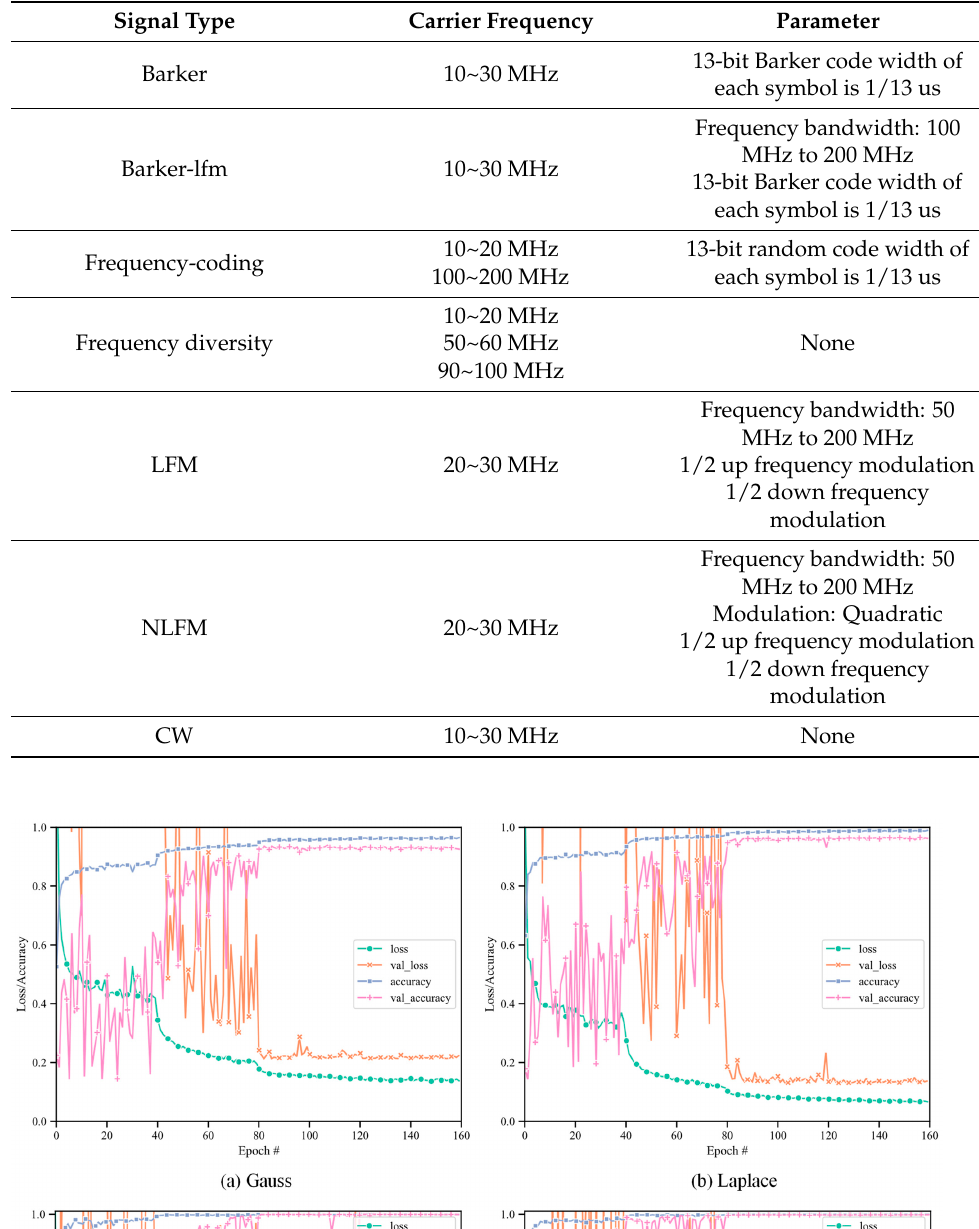
Table 2. Specific parameters of seven types of radar emitter signals.